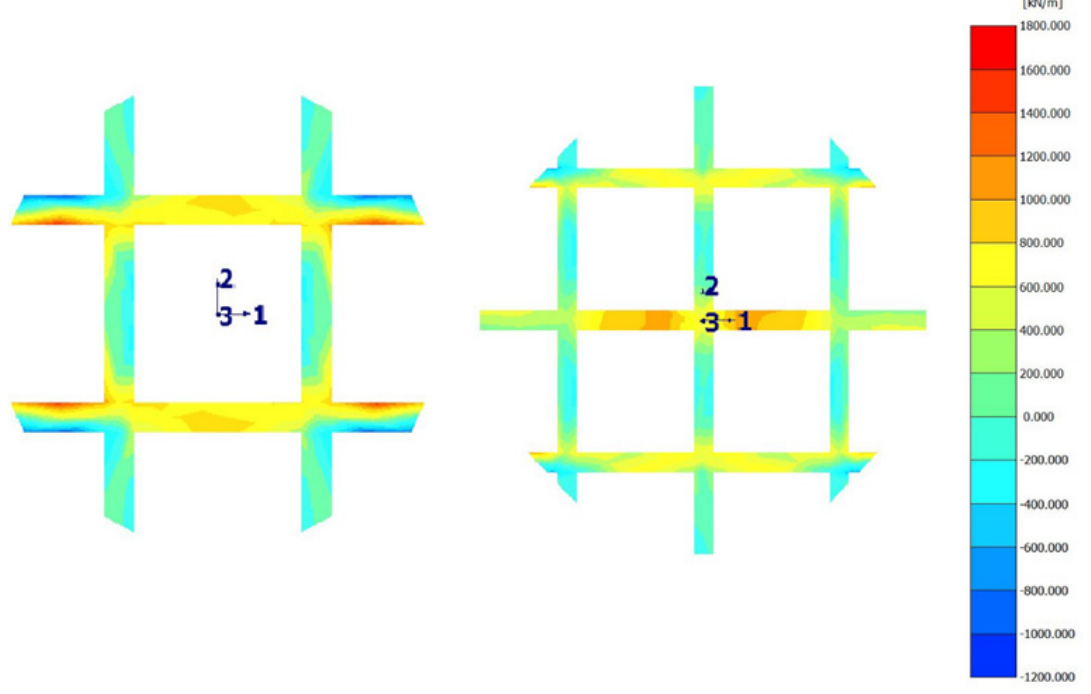
= 300 kPa: left – sample reinforced with 3